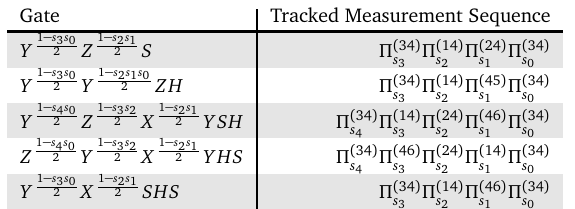
Table 23: Pauli gate corrections tracked for the corresponding single-qubit gates implemented using Majorana-Pauli tracking methods. The implicit action on the 1 − sns 0 Π ( 34 ) ancillary qubit is X for sequences of length n . 2 s 0